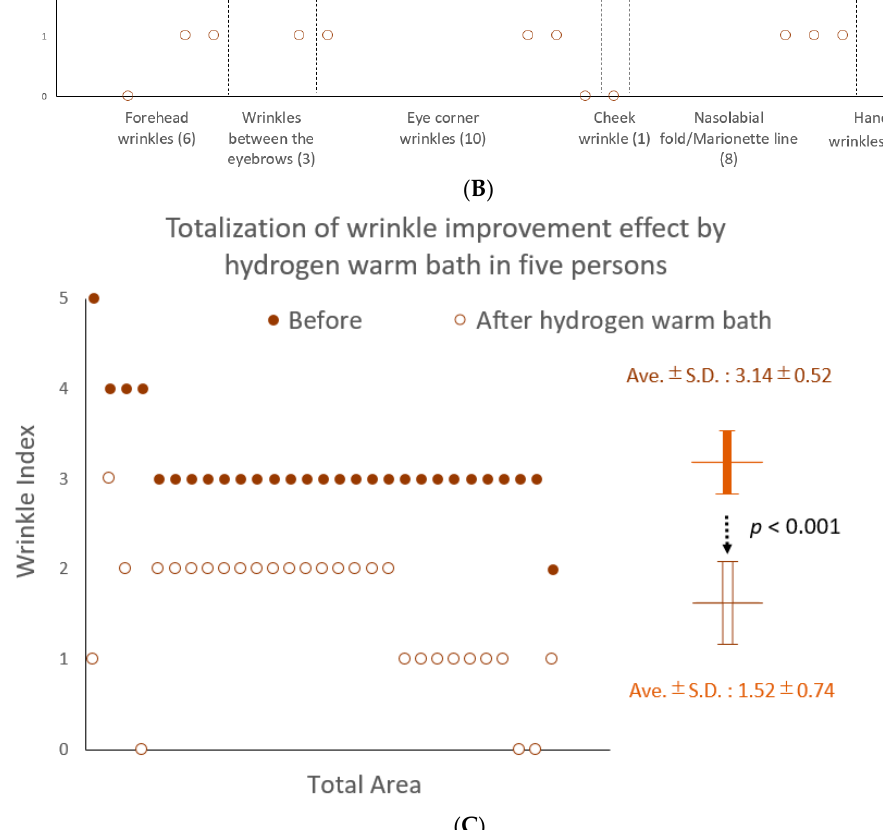
Figure 2. Effects of long-term daily usage of hydrogen warm-water bath and poultice on wrinkles on the skin of face. ( A ): Dot graph indicating change in the degrees within seven hierarchies before and after hydrogen warm bath, as divided by loci of all subjects. Vertical axis shows the wrinkle index, while horizontal axis shows the numbering of analyzed areas for each subject, as follows; 1: cheek blotch, 2: blotch of outer corner of the eye, 3: wide-ranged cheek blotch, 4: upper-outside-arm dispersed blotch (Right), 5: neck dispersed blotch, 6: jaw blotch, 7: eye-corner blotch, 8: hand blotch. ( B ): Dot graph indicating change in degrees with seven hierarchies before and after bathing, as divided by each region of all subjects. ( C ): Dot graph indicating change in degrees with seven hierarchies before and after bathing for total loci of all subjects (n = 29).